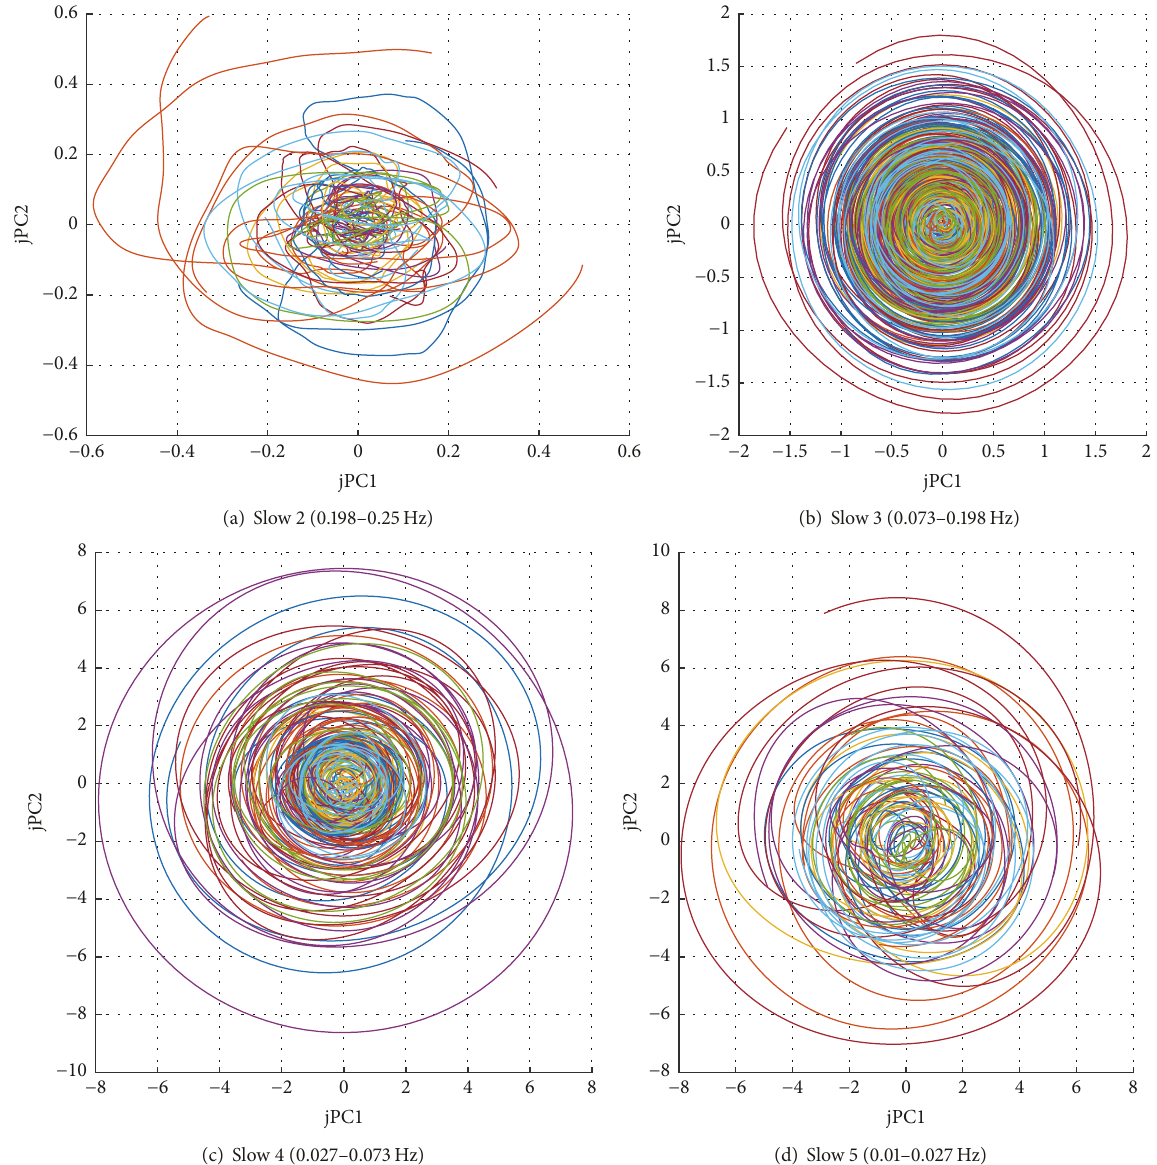
Figure 2: BOLD trajectories after projection with jPCA (one color represents one person of the young group; all trajectories were obtained with cubic spline